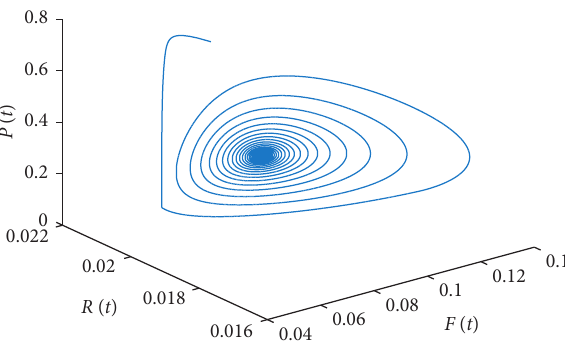
Figure 6: Portrait diagram of land model (30) with ϕ � 0 . 90, � 728 . 403. τ � 700 < τ 0